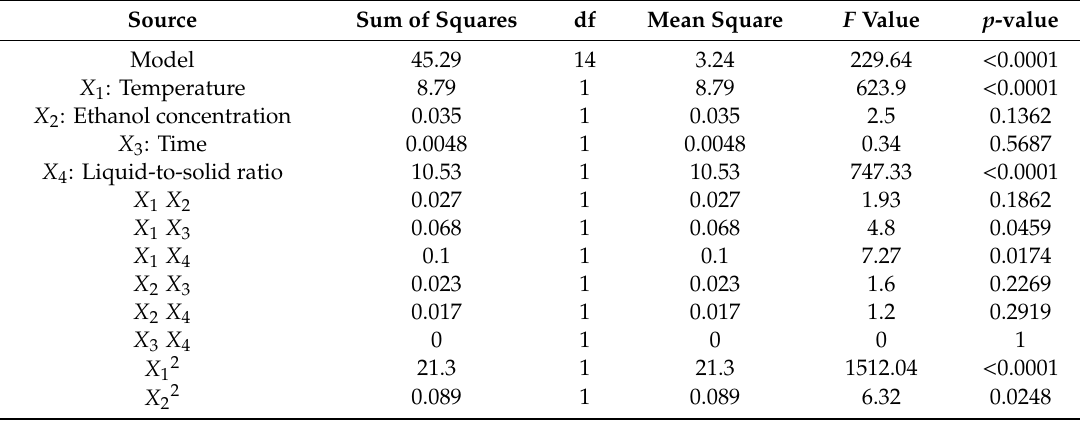
Table 2. Analysis of variance (ANOVA) for the response surface quadratic